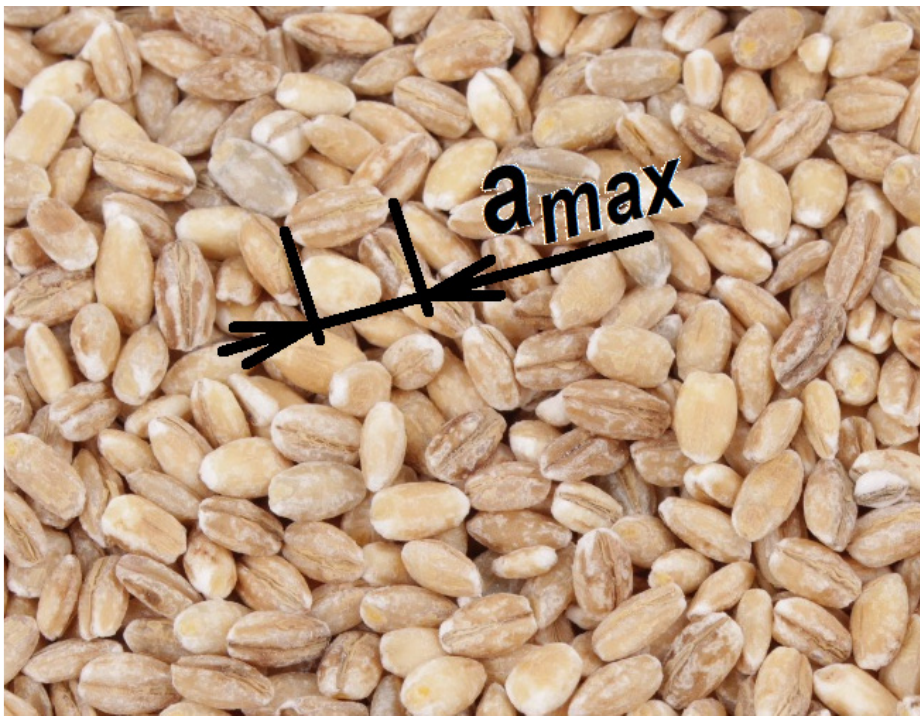
Figure 4. Wheat grain and its